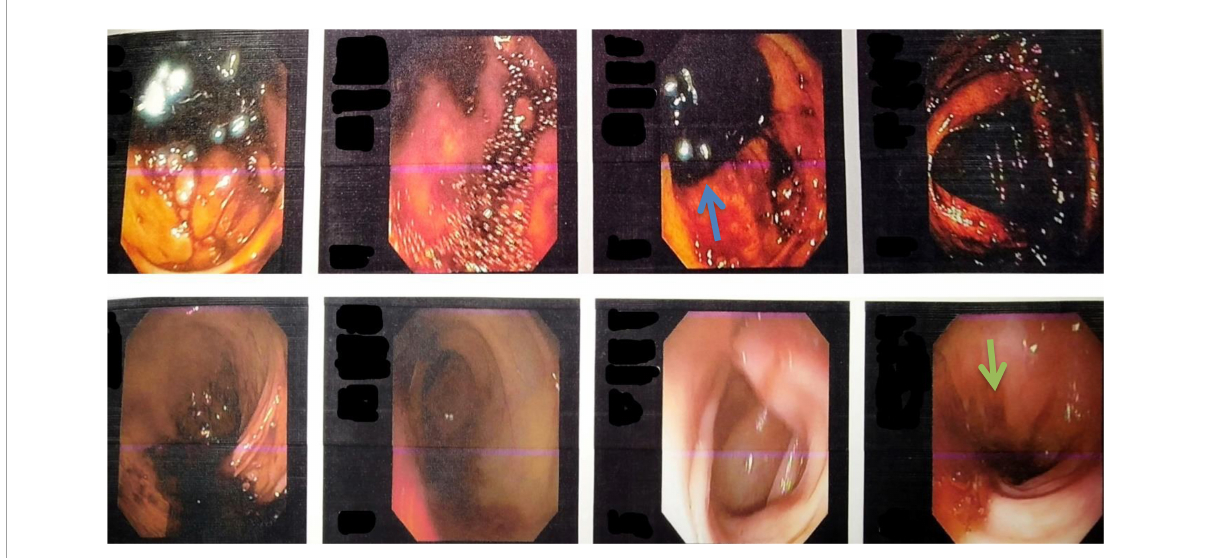
FIGURE2 Colonoscopy images showing the presence of melanic stools in the cecum, ascending colon, and transverse colon (blue arrow), suggesting upper gastrointestinal bleed. The image also shows multiple telangiectasias in the rectosigmoid region (green arrow).